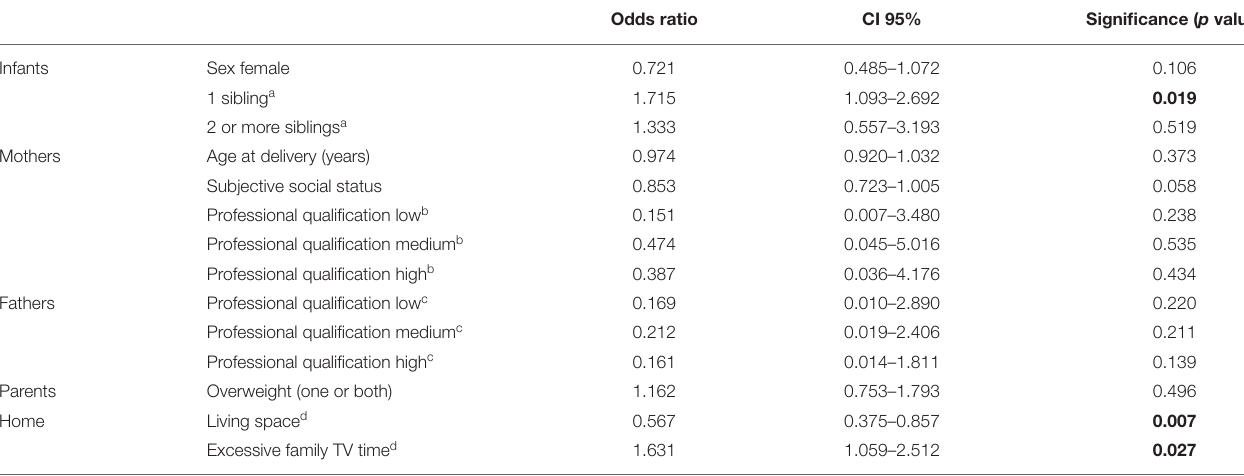
TABLE 4 | Multivariable logistic regression analysis of possible predictors and infant screen time * ( N = 441, Nagelkerkes-R 2 = 0.108). Odds ratio CI 95% Significance ( p